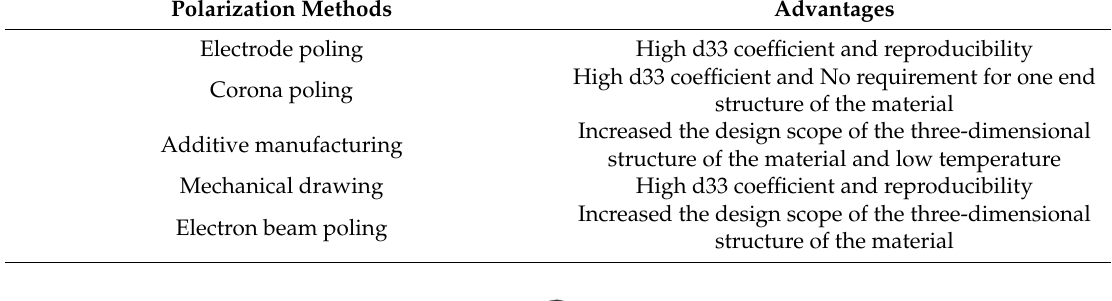
Table 1. The advantages of various polarization methods.